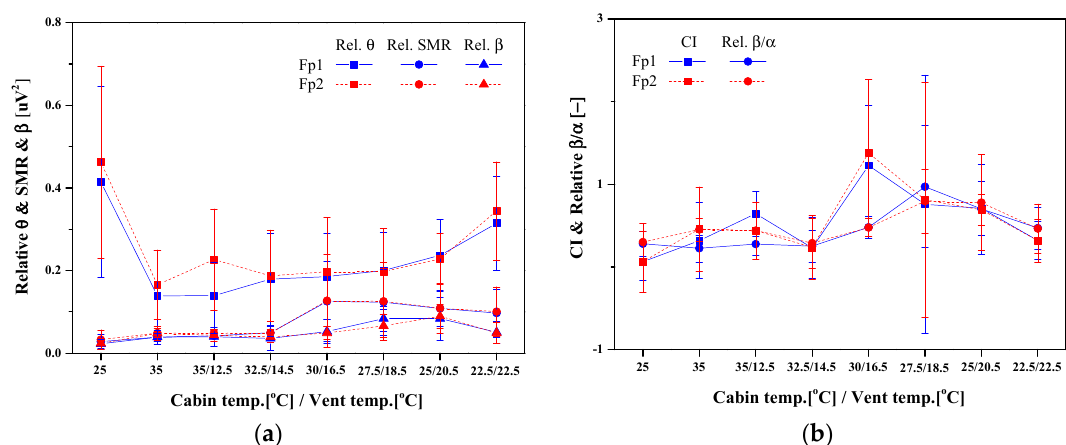
Figure 10. Variations of concentration index (CI), relative β / α -, θ -, sensory motor rhythm (SMR), and β -waves at the prefrontal lobe. ( a ) Relative θ -wave, SMR, and β -wave; ( b ) CI and relative β / α -wave. The relative θ -, SMR, and β -waves are the indicators of the concentration of the